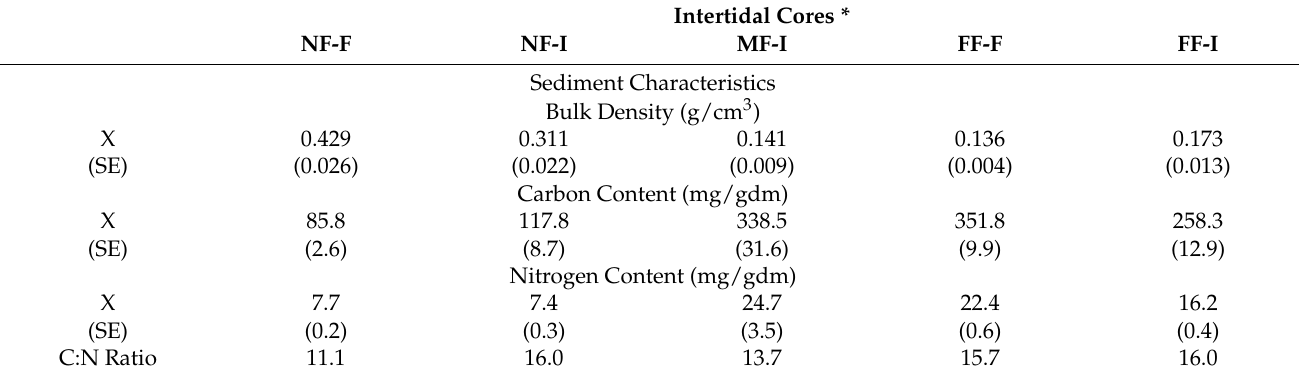
Table 5. Physical and chemical characteristics of sediments used in subtidal and intertidal cores to measure benthic fluxes. Intertidal Cores